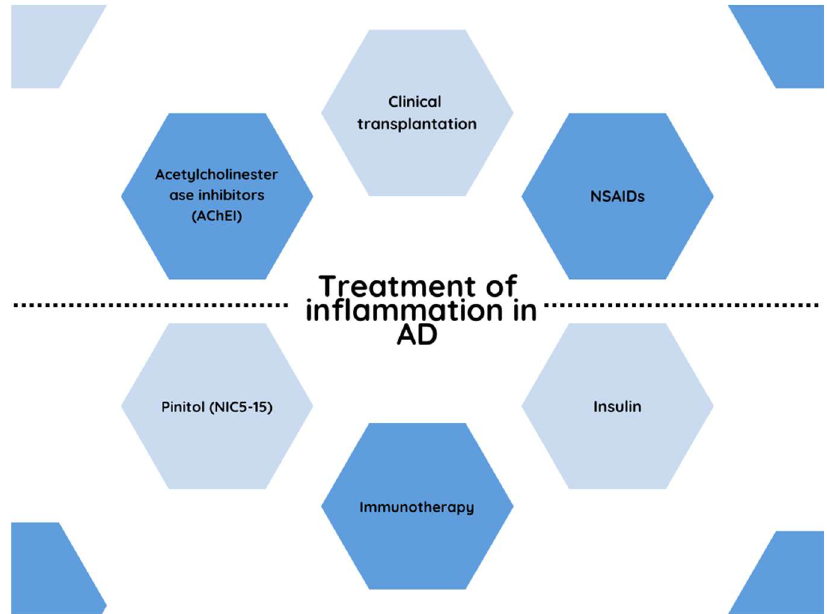
Figure 2. Current treatment strategies used in therapy of inflammation in Alzheimer’s disease.